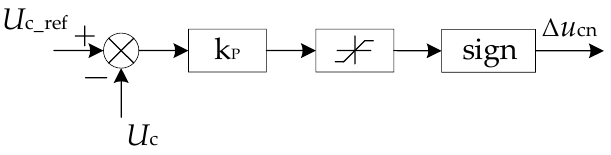
Figure 16. Inter-cluster voltage control chart.